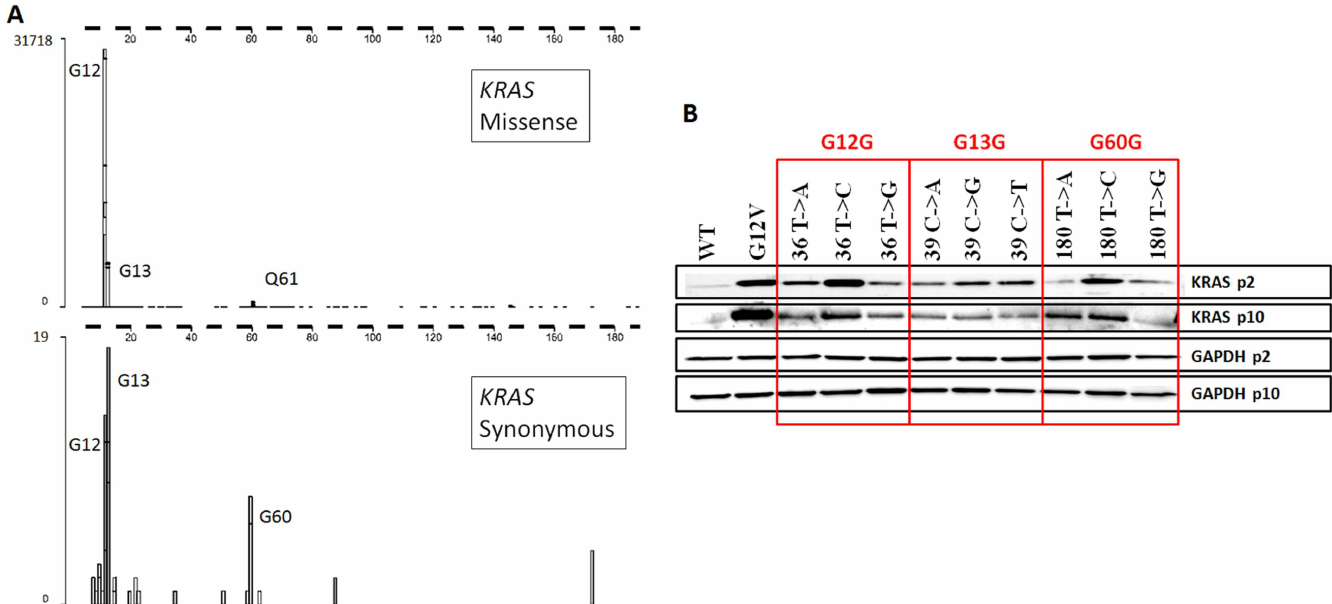
Fig 1. Synonymous KRAS mutations found in human tumors increased KRAS protein expression. (A) Positions and frequenciesof missense (top panel) and synonymous (bottom panel) mutations found in KRAS genes in human cancers, as of 27 January 2016. Source: Catalogueof Somatic Mutations in Cancer. (B) NIH 3 T 3 cell lines stably transfected with KRAS containingsingle synonymousglycine mutations at G12, G13, or G60 overexpress KRAS protein compared to wild type KRAS . p2 = passage 2, p10 = passage 10.